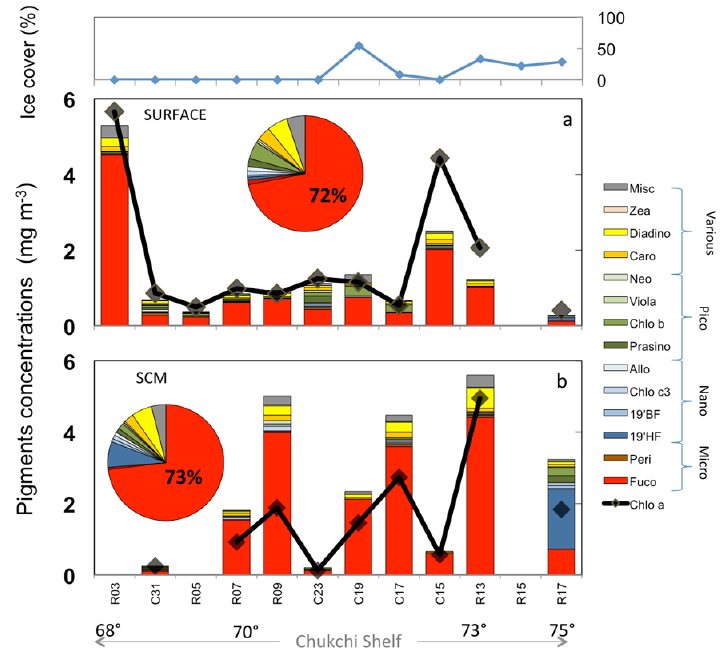
Fig. 2. Concentrations of Chlorophyll a (Chl a ) and major accessory phytoplankton pigments (in mgm − 3 ) (see Table 1 for pigment acronyms) over the Chukchi Shelf in (a) surface waters and (b) in the SCM. The miscellaneous group (Misc) refers to pigments